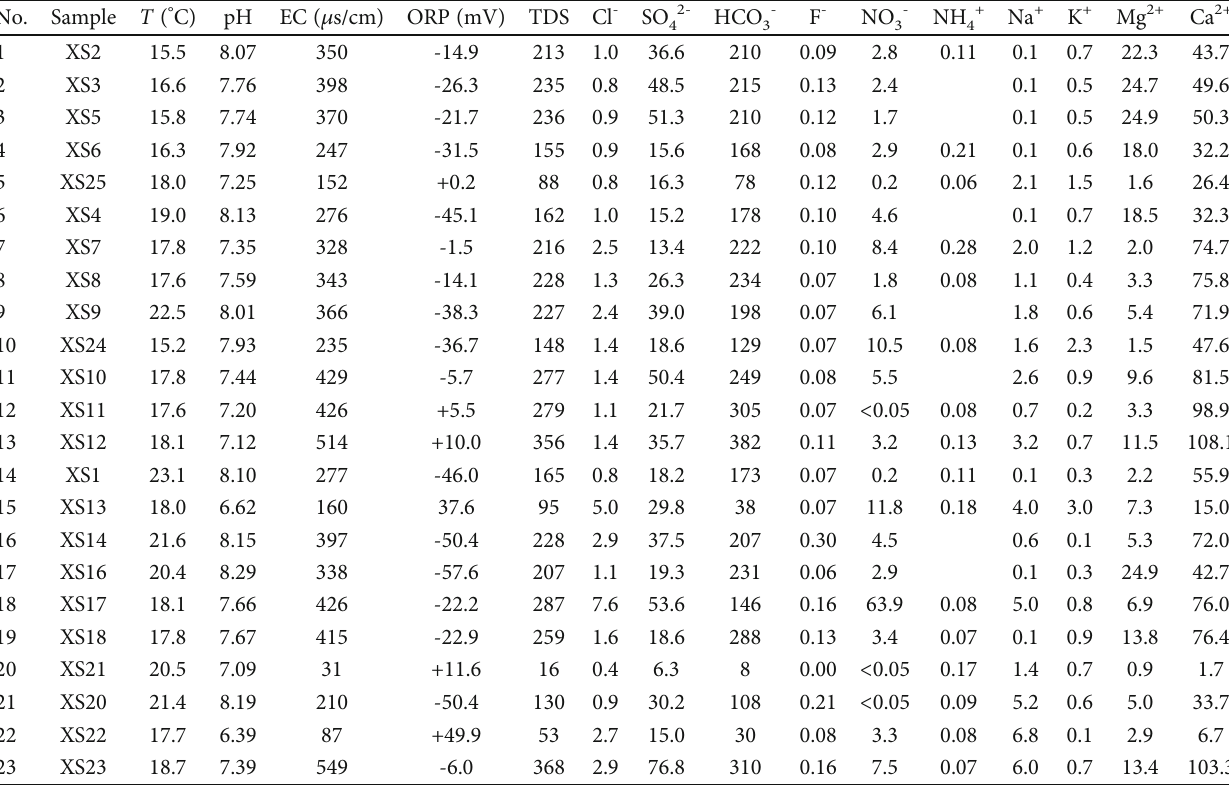
Table 2: Geochemical composition of spring water